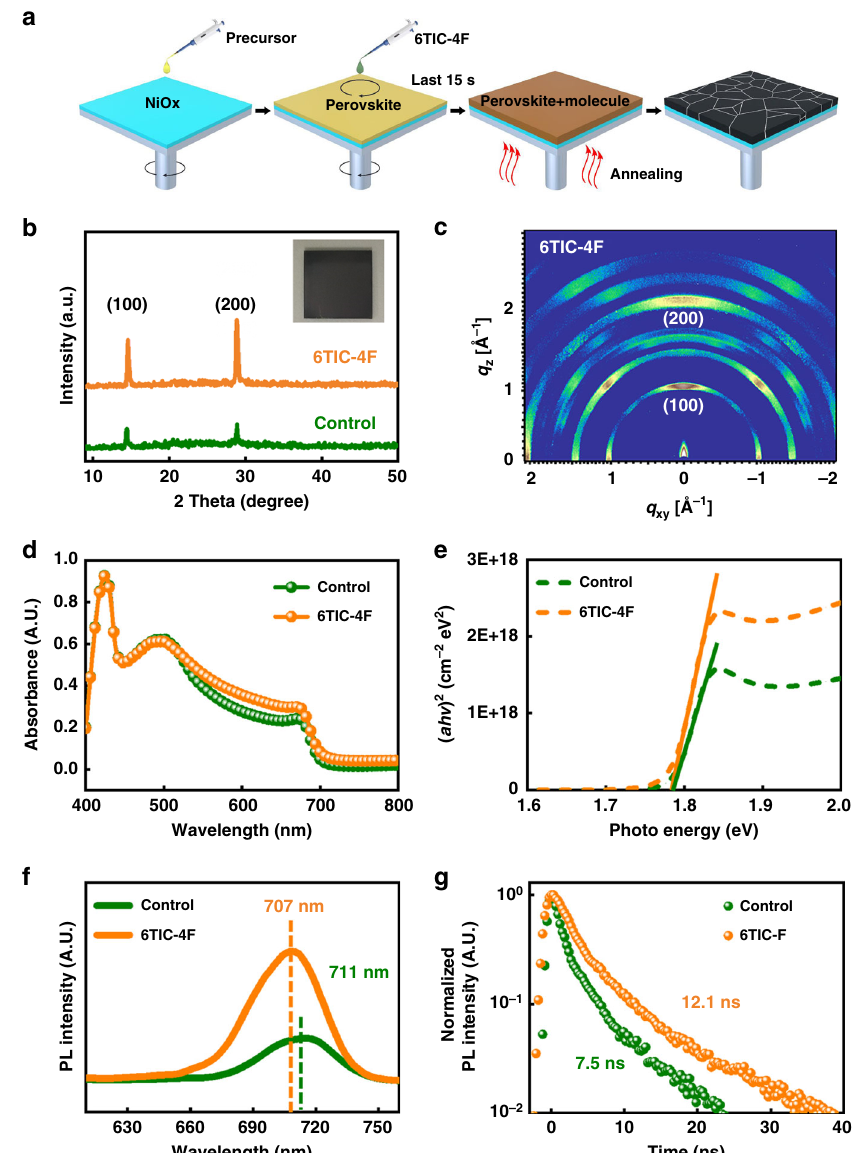
Fig. 1 Film fabrication and characterization. a Illustration of the deposition processes of the prepared CsPbBr x I 3 − x fi lm in this study. b X-ray diffraction patterns, (inset: the photograph of CsPbBr x I 3 − x fi lm with 6TIC-4F treatment), c grazing incidence wide-angle X-ray scattering, and d , e the UV – vis absorption spectra and Tauc plot of the prepared CsPbI x Br 3 − x fi lms without (green) and with (orange) 6TIC-4F passivation. f Steady-state photoluminescence (SSPL) spectra and g normalized time-resolved photoluminescence (TRPL) decay pro fi les of the studied CsPbBr x I 3 − x fi lms without (green) and with (orange) 6TIC-4F passivation on quartz